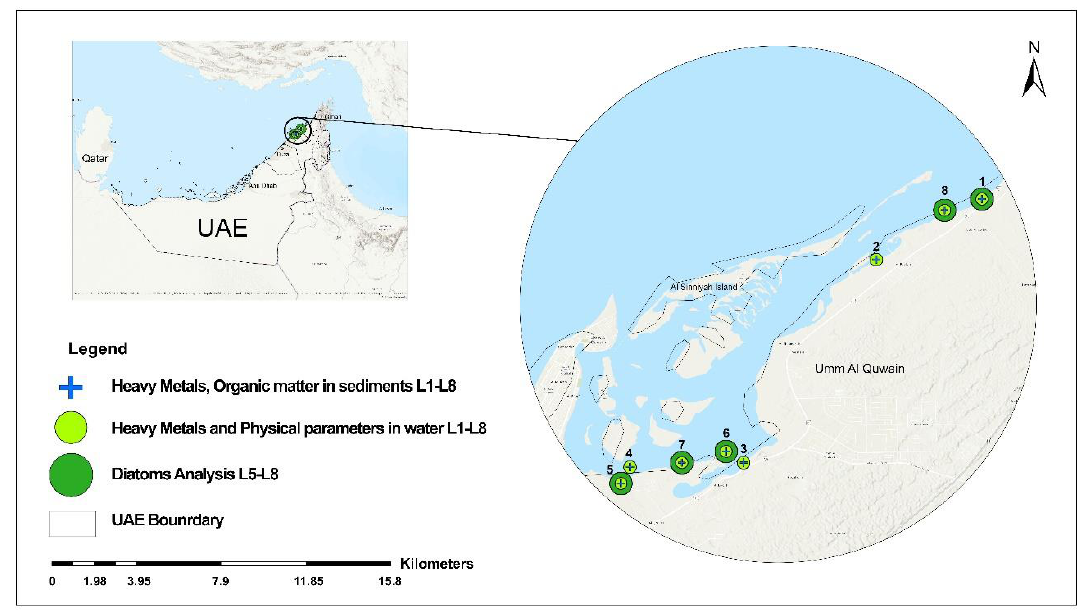
Figure 1. Sampling Locations from Umm Al Quwain Mangroves, United Arab Emirates.